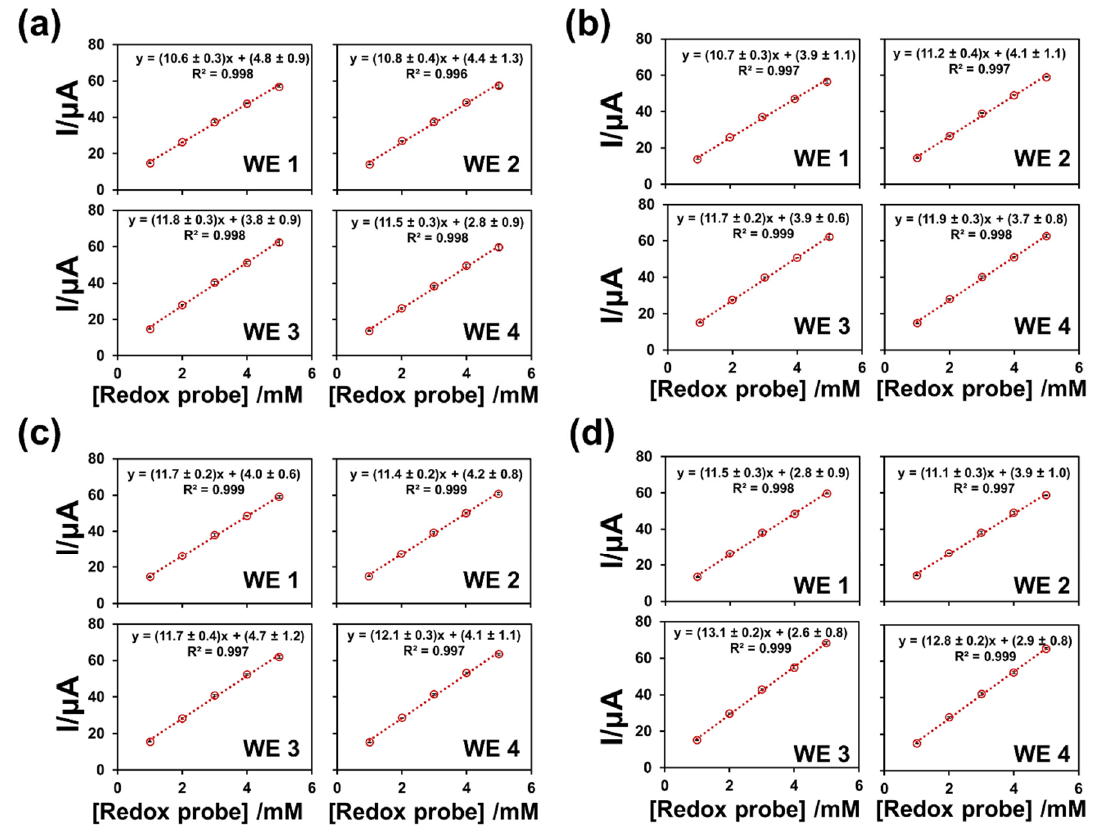
Figure 5. The calibration plot of different concentration of Fe(CN 6 ) 3 − /4 − at different four platforms were obtained from MGrE1 ( a ), MGrE2 ( b ), MGrE3 ( c ), MGrE4 ( d ) carried in 0.1 M KCl.